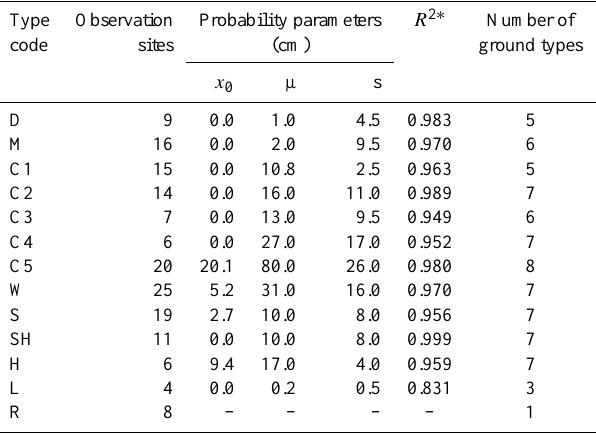
Table 2. Parameter values of the probability distribution equation for organic layer thickness and the number of ground types for each land cover type estimated using field